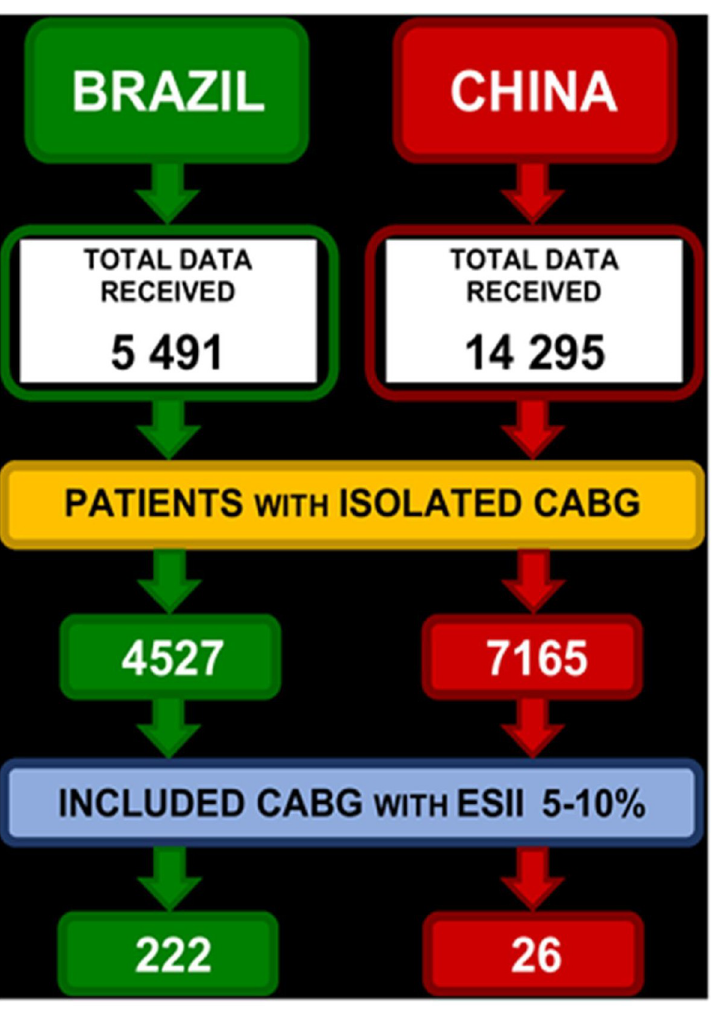
Fig 1. Flowchart of selection and recruitment of high-risk patients undergoing CABG—HiriSCORE database, 2019.